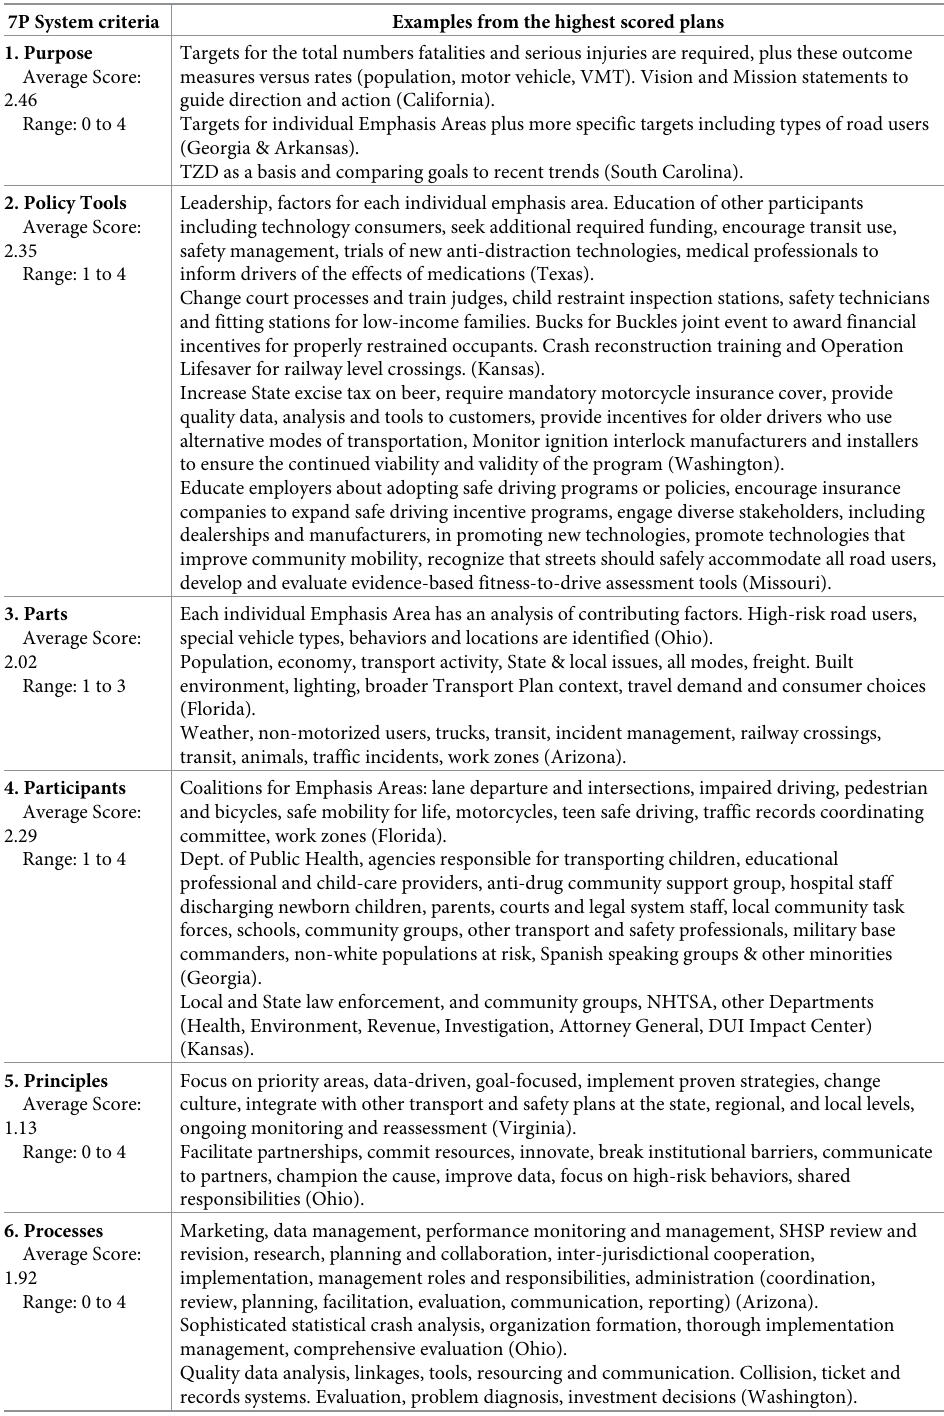
Table 4. Summary of 7P system criteria